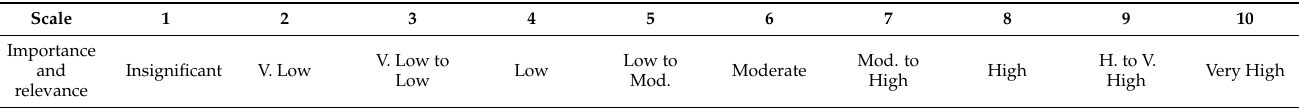
Table 1. Scale of importance and relevance of indicators and sub-indicators to the physical flood vulnerability.